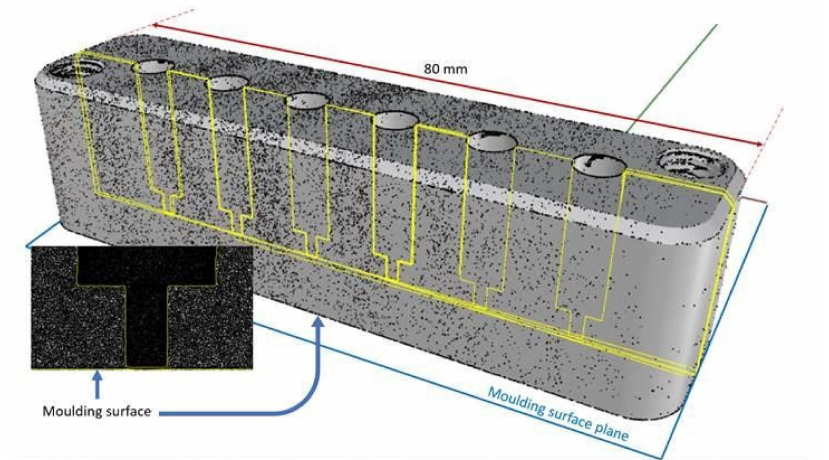
Figure 3. An X-ray CT of one of the mould inserts used in this work. The insert shows an enlarged 139 image showing the thin “window” at the base of each blind